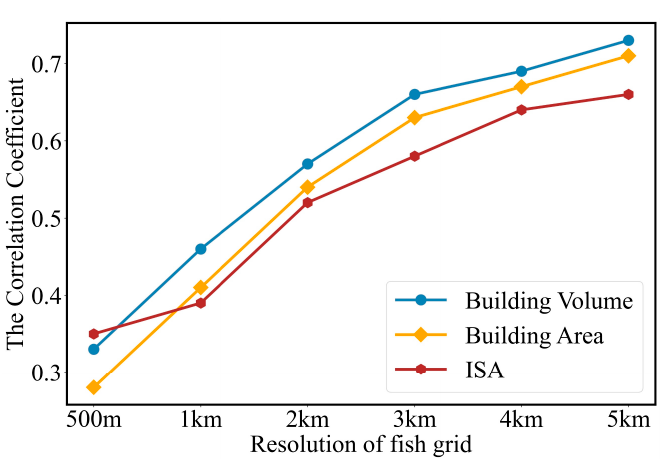
Figure 4. Pearson correlation coefficients between three indicators (i.e., building volume, building area, and ISA) and NTL data at six resolutions.